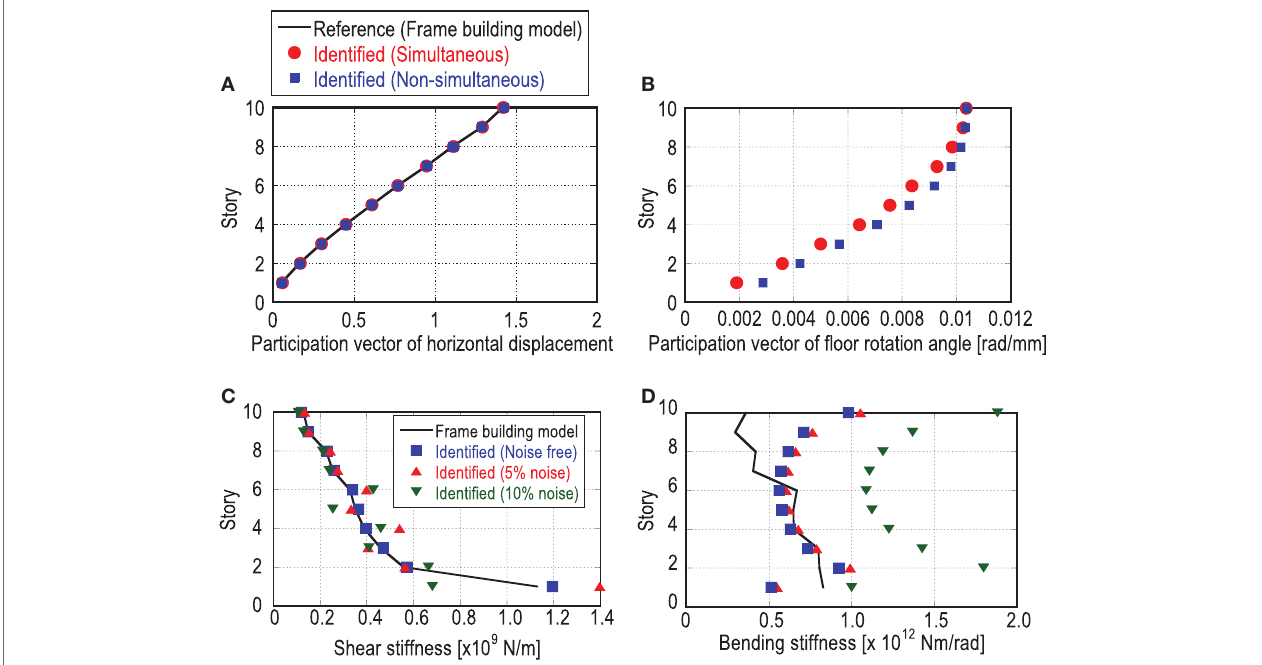
FIGURE 9 | Identified shear stiffness and bending stiffness in non-simultaneous measurement. (A) Identified participation vector of horizontal displacement, (B) identified participation vector of floor rotation angle, (C) identified shear stiffness, and (D) identified bending stiffness.